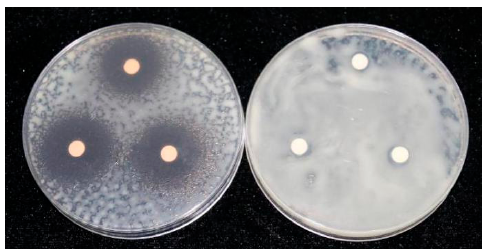
Figure 2. Effect of DIMBOA and 1% DMSO on the growth of R. solanacearum at the concentration of 300 μ g/disc.